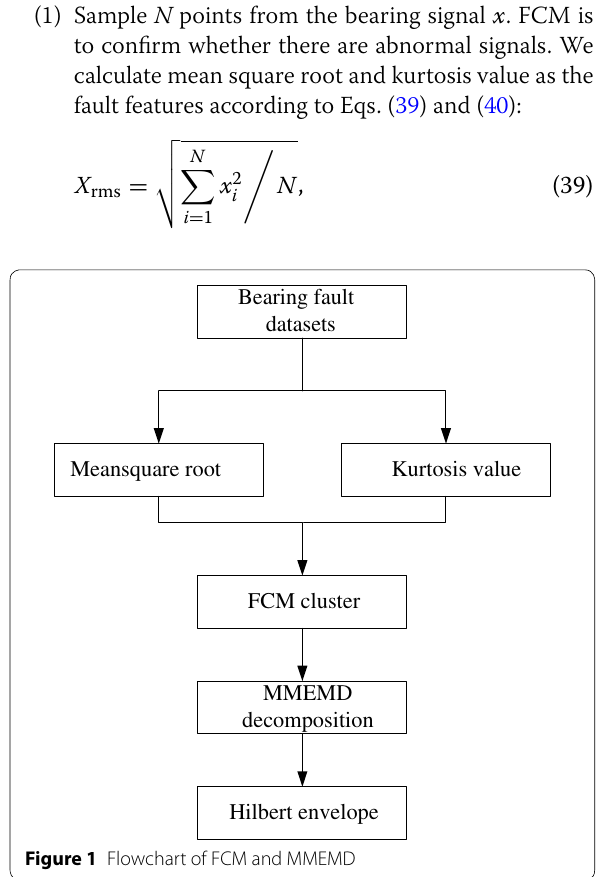
Figure 1 Flowchart of FCM and